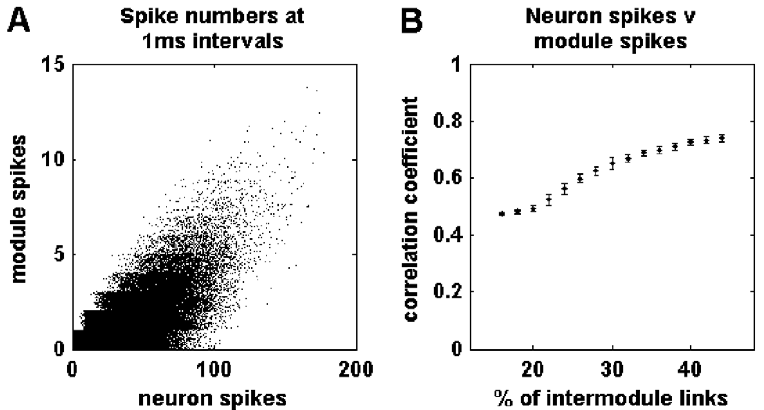
Figure 3. Relationship between neuron spikes and module spikes. (a) An illustrative scatter plot of the numbers of neuron spikes and module spikes at sampled 1 ms intervals. Integer spike numbers were jittered by the addition of uniformly distributed random numbers between 0 and 1 . (b) Correlation coefficients between numbers of neuron spikes and numbers of module spikes as a function of network randomization. Correlations were computed from five-minute spike rasters. Error bars represent the standard error of the mean from 20